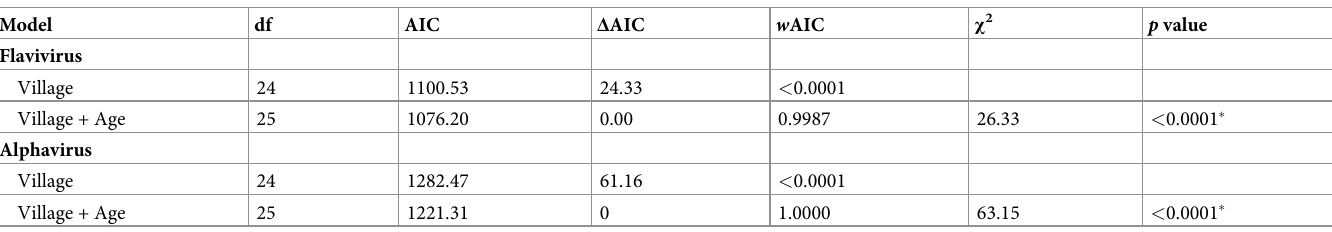
Model comparison was made on the basis Δ AIC, w AIC and goodness-of-fit using maximum likelihood estimation. The full list of explanatory variables included village, sex, temperature, age and bednet